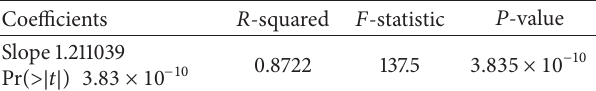
Figure 3: Comparison of the contents of gallic acid, ellagic acid, and eugenol in Syzygium aromaticum (SA) and Syzygium aromaticum combinedwith Curcumaaromatica (SAC).Significanceofdifference represented as ∗∗ 𝑃 < 0.01 and ∗∗∗ 𝑃 < 0.001 .